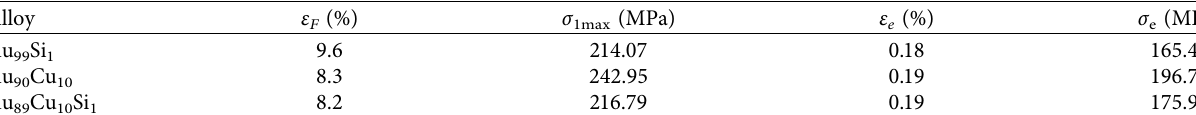
Table 4: Values of ε � f F ( f ( ε F ) max ), σ 1max , ε e , and σ e for Au 99 Si 1 , Au 90 Cu 10 , and Au 89 Cu 10 Si 1 at